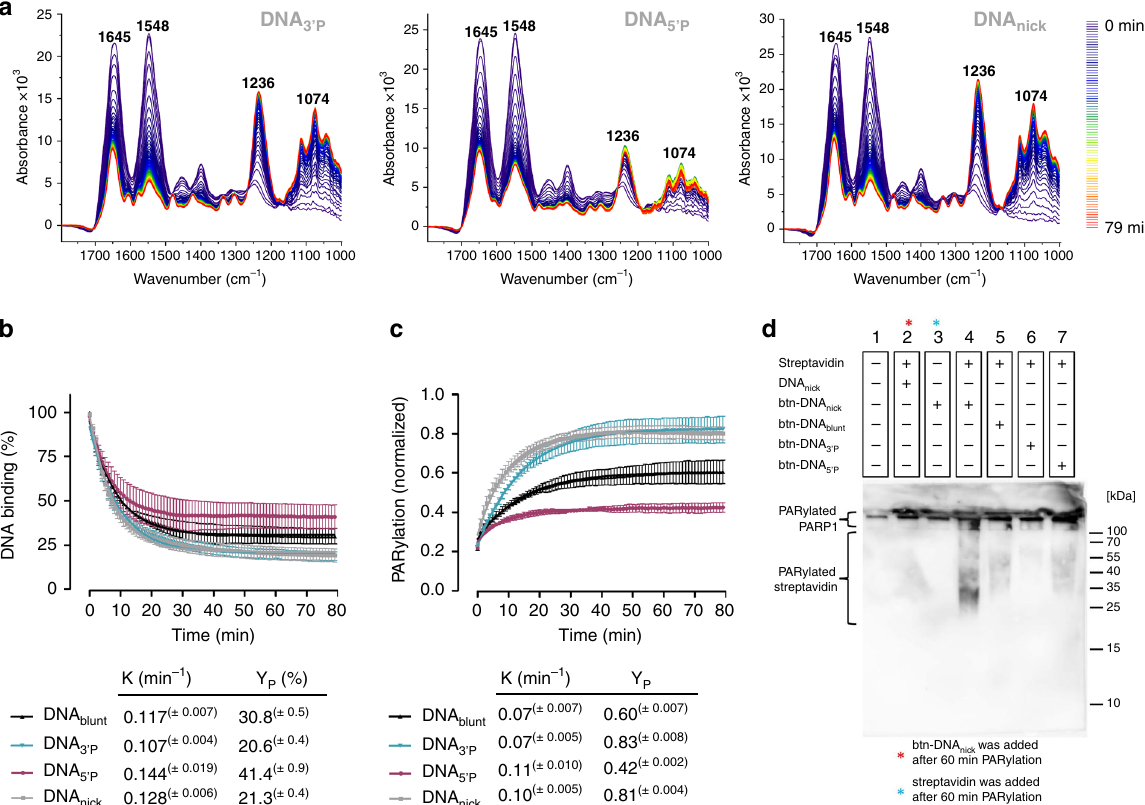
Fig. 4 Real-time monitoring of PARP1-dependent PARylation at various DNA strand break models. a Representative time-dependent spectra following the addition of 100 µ M NAD + to PARP1 bound to immobilised DNA 3 ’ P , DNA 5 ’ P or DNA nick . Amide I (1645 cm − 1 ) and amide II (1548 cm − 1 ) bands of PARP1 and anti-symmetric (1236 cm − 1 ) and symmetric (1074 cm − 1 ) phosphate vibrations of generated PAR are indicated. b , c Evaluation of a . ‘ 0 min ’ refers to start of measurements. b Dissociation of PARP1 from DNA blunt , DNA 3 ’ P , DNA 5 ’ P or DNA nick upon addition of NAD + . Time-dependent intensity decrease of the amide II band (1548 cm − 1 ) was analysed. Intensity of the amide II band before addition of NAD + was set to 100%. PARP1 dissociation parameters were calculated via a mono-exponential fi t function. c PAR formation upon addition of NAD + . Time-dependent intensity increase of the anti-symmetric phosphate vibration of PAR (1236 cm − 1 ) was analysed. Data were normalised to the intensity of the amide II bands (1548 cm − 1 ) of PARP1 before addition of NAD + . PAR formation parameters were calculated via a mono-exponential fi t function. b , c Data from same experiments. Means ± SEM of n = 3 independent experiments. d Analysis of covalent PARylation of streptavidin in the presence of biotinylated (btn-DNA) and non-biotinylated DNA (DNA) via western blot and subsequent immunodetection of PAR. PARP1 (1 µ M) and NAD + (500 µ M) were present in all samples. Immunodetection of PARP1 is shown in Supplementary Fig. 3e. Source data are provided as a Source Data fi